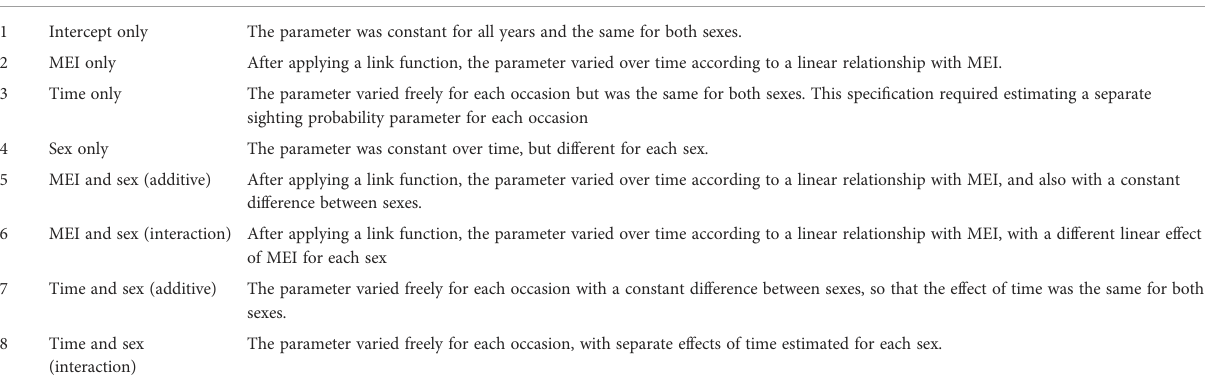
TABLE 1 Description of model speci fi cations for the sighting probabilities, survival probabilities, and per capita recruitment rates of M. alfredi subpopulations in Dampier Strait and SE Misool